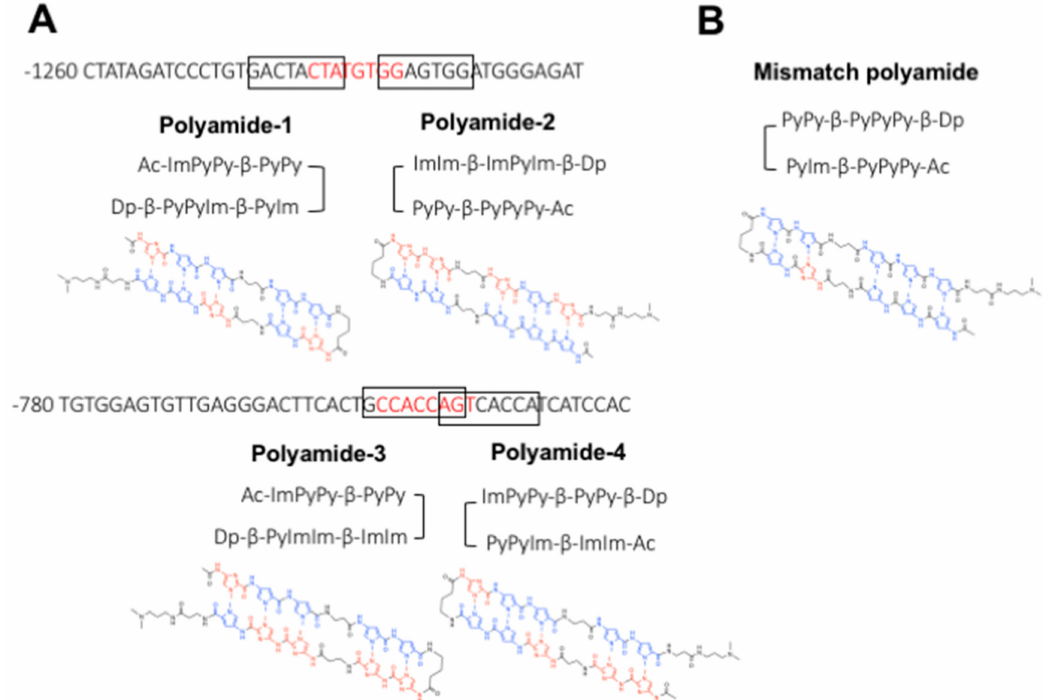
Figure 11. Structure of pyrrole-imidazole (PI) polyamide to prevent the binding of upstream stimulatory factor 1 (USF1) on the transforming growth factor (TGF)- β 1 promoter. Polyamides were synthesized by solid-phase methods and were purified by HPLC (0.1% AcOH/CH3CN 0 to 50% linear gradient, 0 to 40 min, 254 nm through a Chemcobond 5-ODS-H column). ( A ) Red capitals are E-box sequences. Boxes indicate the binding site of PI polyamides on the TGF- β 1 promoter. Pyrrole structure is indicated by the blue color and imidazole structure is indicated by the red color. ( B ) Structure of mismatch